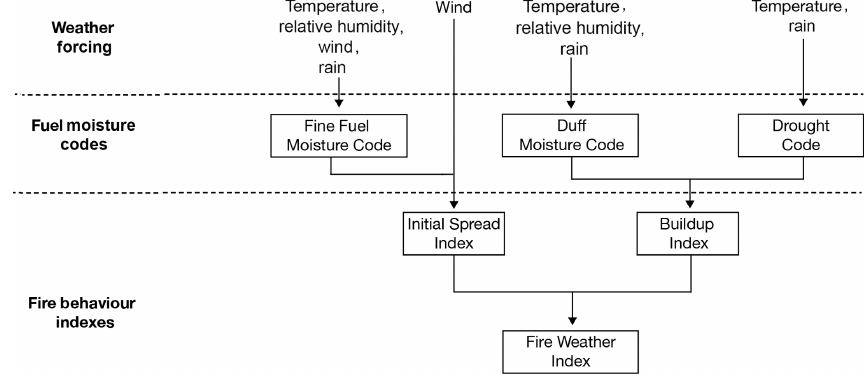
Figure 9. Schematic structure of the